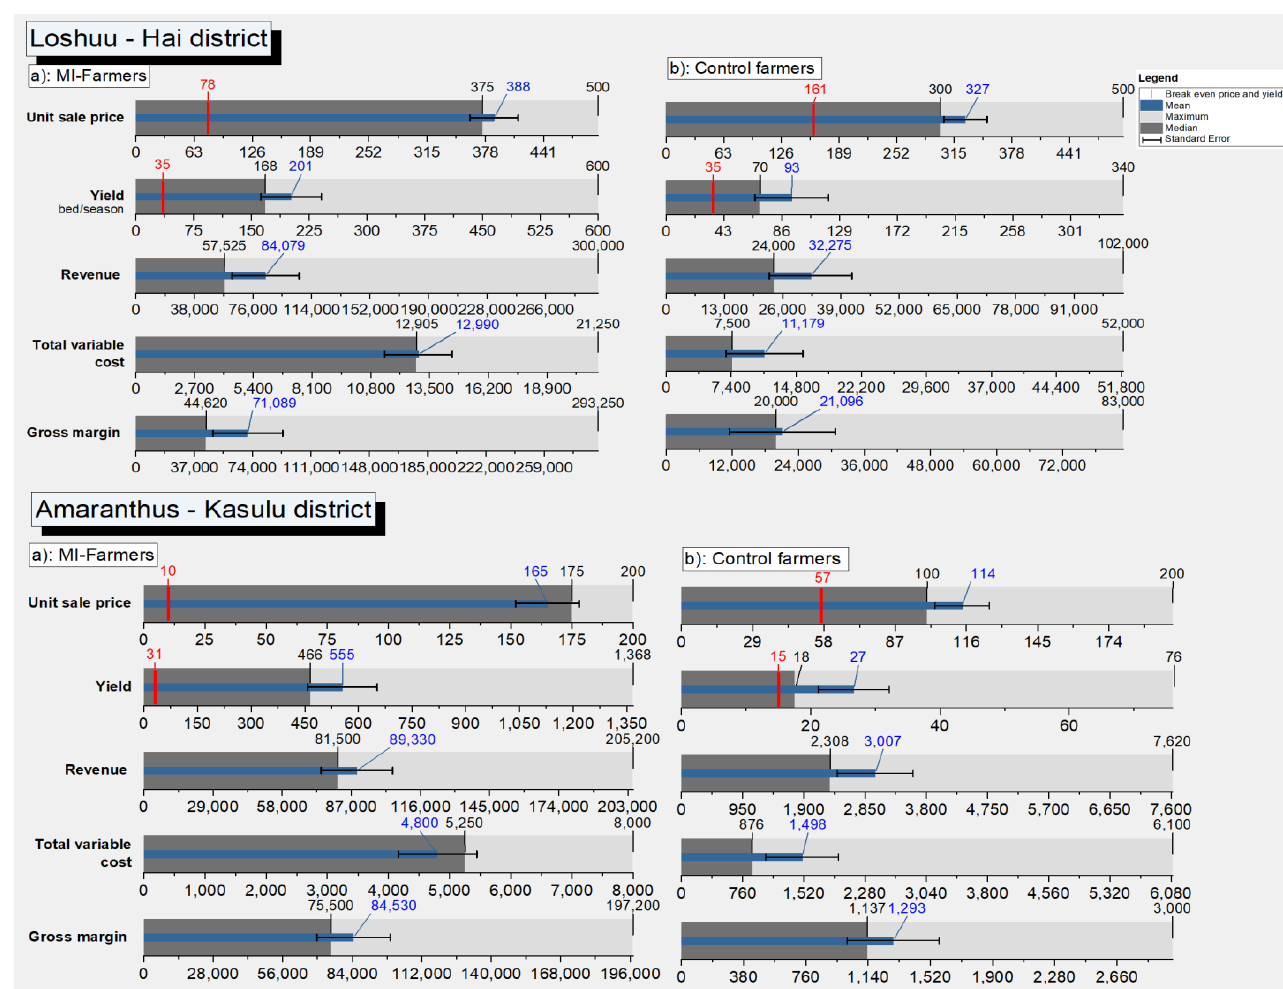
Figure 4. Enterprise comparison of MI farmers ( a ) and control farmers ( b ) growing Loshuu (Hai district) and Amaranthus (Kasulu district). Price, revenue, total variable cost (TVC), and gross margin (GM) amounts are presented in Tanzanian Shilling (TSh), where 1 USD = 2330 TSh and 1 TSh = 0.00043 USD. Yield is calculated as per bed per season. Standard error of mean is presented as error bars for each bar graph.